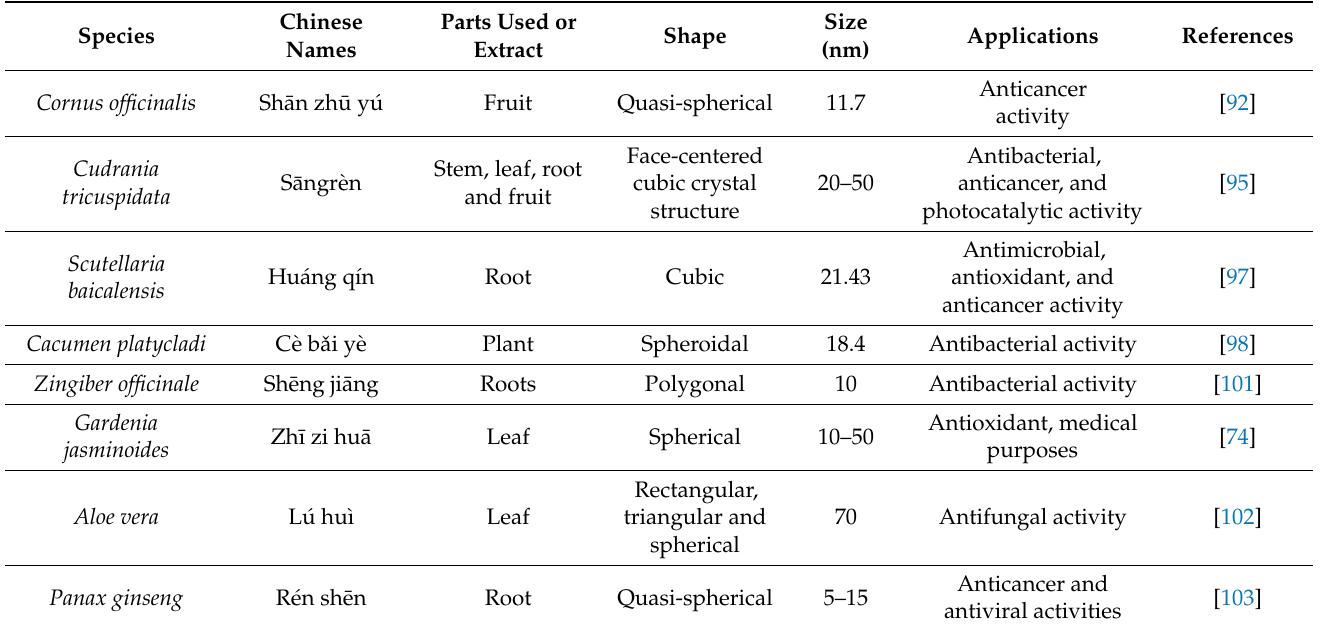
Table 1. Chinese herbal synthesis of silver nanoparticles and their biomedical